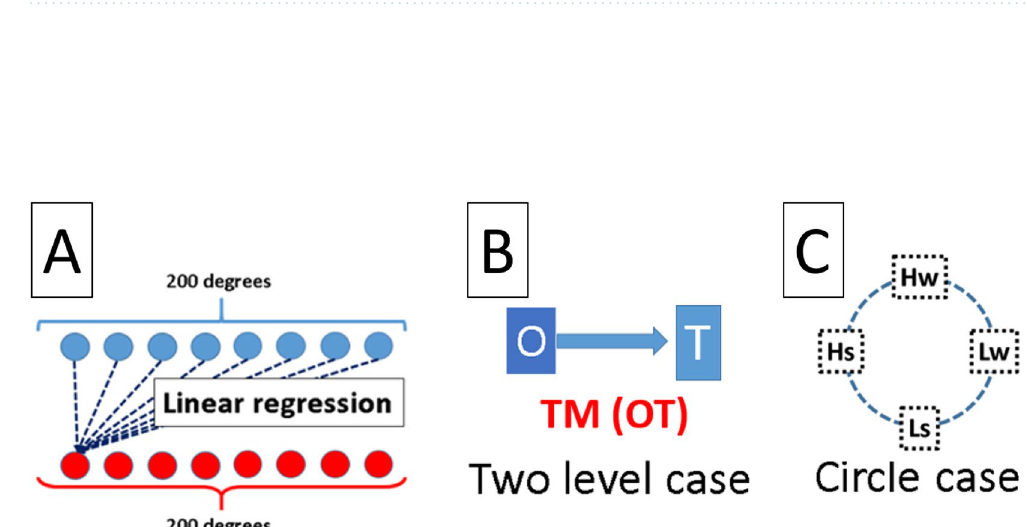
Figure 3. Plot ( A ) shows the decision tree of HS, HW, LS, and LW states. In contrast, plot ( B ) is of HS and HW states, and plot ( C ) of LS and LW states.